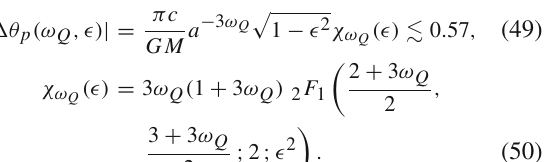
Table5 Valuesoftheparameter ω Q obtainedfrom(45)usingthevalues of periastron advance for planets of the Solar System Planet η